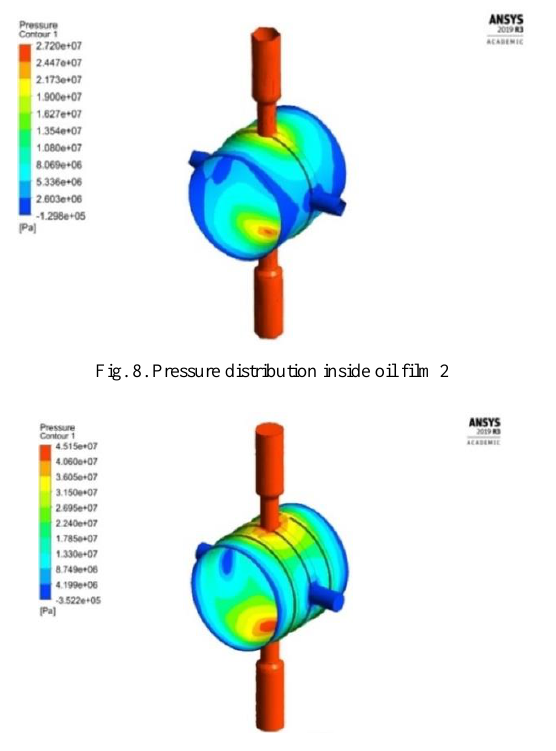
Fig. 9. Pressure distribution inside oil film 3